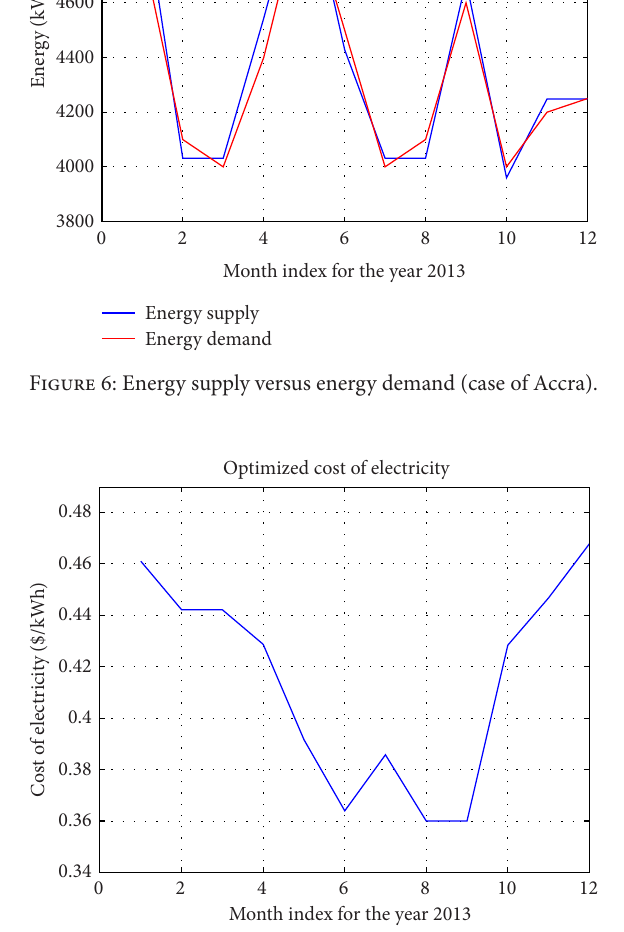
Figure 7: Cost of hybrid electricity (case of